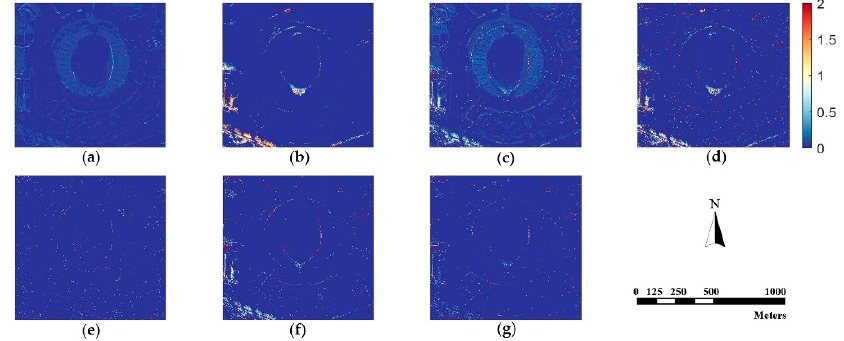
Figure 6. The difference image between the fused images and the referenced MS image for WorldView-2 data. ( a ) GS; ( b ) AIHS; ( c ) WT-SR; ( d ) WT-IHS; ( e ) CT-ICA; ( f ) CSI; ( g ) proposed.